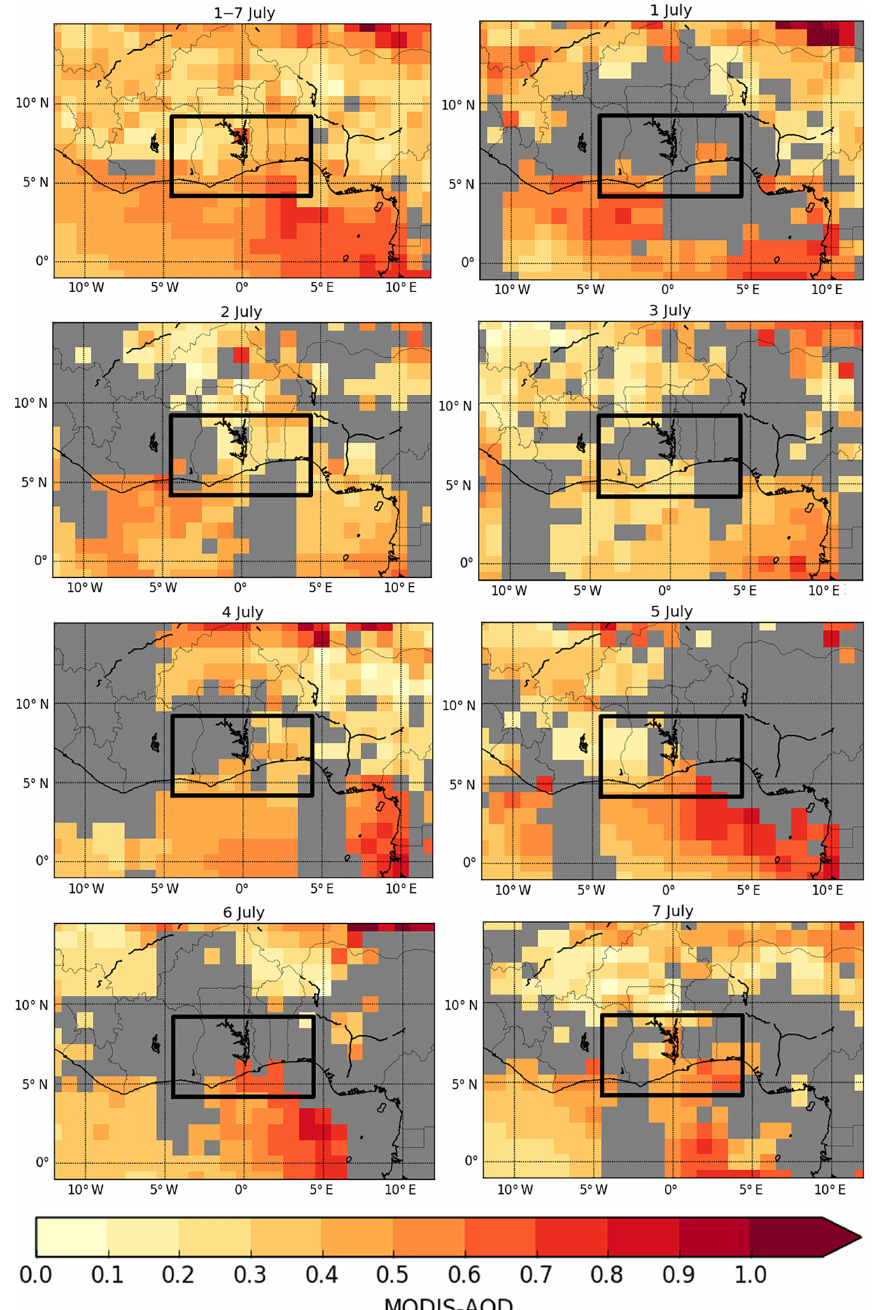
Figure A1. MODIS AOD daily average of two products acquired by Aqua and Terra (the combined Dark Target and Deep Blue MYD08-D3 and MOD08-D3 products, respectively) over the 1–7 July 2016 period (top left) and over each day of the period. Data excluded by the cloud screening process are in gray. The modeling domain is presented by the black